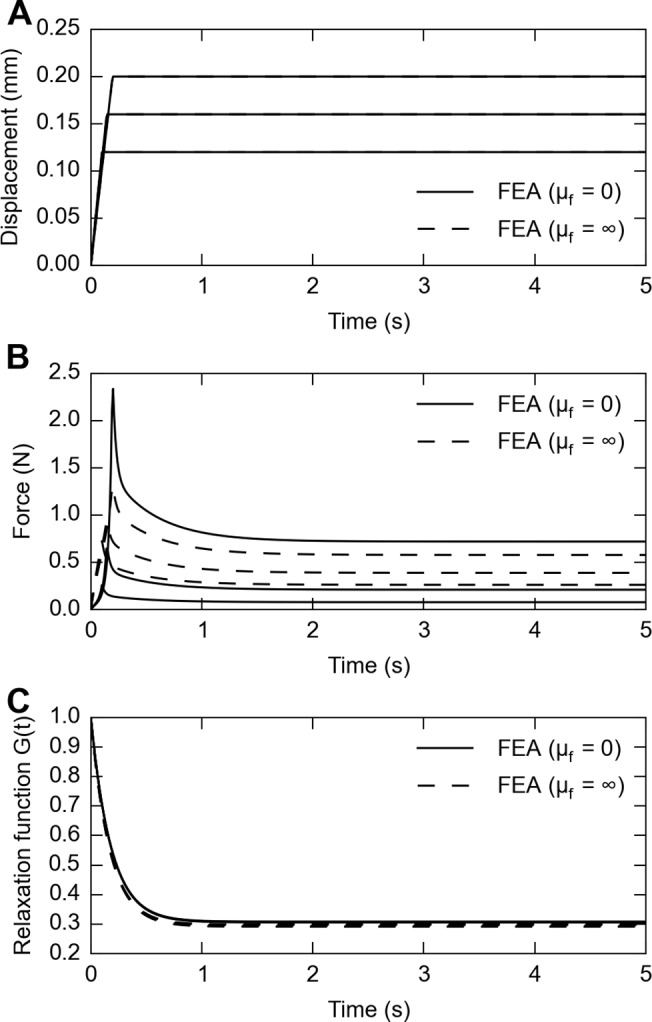
FE simulations for a skin thickness of 400 μm, at stretch levels of 0.5, 0.6 and 0.7, under frictionless (solid lines) and rough (dashed lines) friction conditions.A: displacement stimuli to achieve desired stretch level; B: responsive force traces for three stretch levels under different frictional conditions; C: calculated relaxation function for force traces shown in B. Note that while frictional conditions have an impact on responsive force traces, they do not impact the calculated viscoelastic reduced relaxation function.